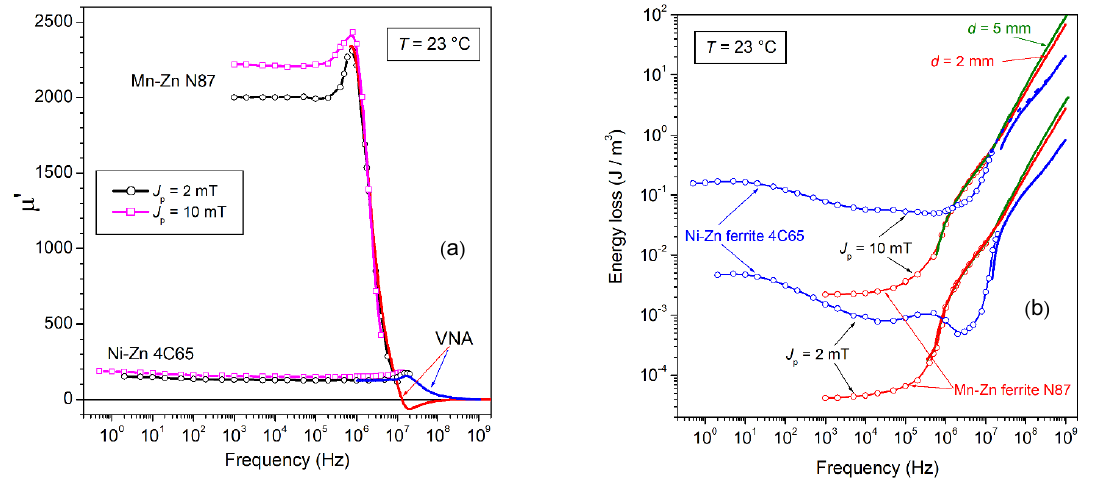
Figure 1. Real permeability component μ′ ( f ) ( a ) and energy loss W ( f ) ( b ), measured versus magnet- izing frequency, up to 1 GHz, in commercial Mn-Zn and Ni-Zn ferrites. The symbols denote the results obtained, up to a few MHz, by fluxmetric measurements. The peak polarization values are J p = 2 mT and J p =10 mT. The continuous lines covering the upper-frequency range are obtained by a transmission line method (Vector Network Analyzer, VNA). Equation (1) is employed to obtain the permeability from the fluxmetrically measured loss W ( f ) at defined J p value. The same equation provides W ( f ) from knowledge of the VNA-measured μ ′ ( f ) and μ ″ ( f ). The eddy current contribution to W ( f ) is singled out beyond some 10 MHz by measurements on 5 mm and 2 mm thick Mn-Zn ring samples.